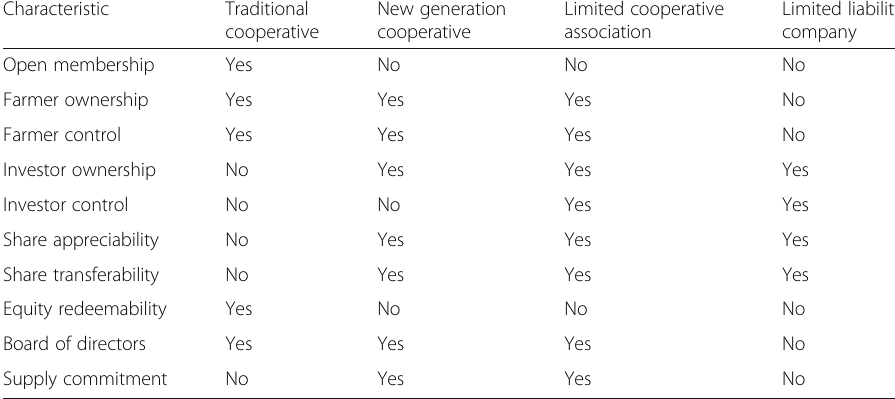
Table 1 Comparison of the ownership and governance characteristics of traditional and hybrid